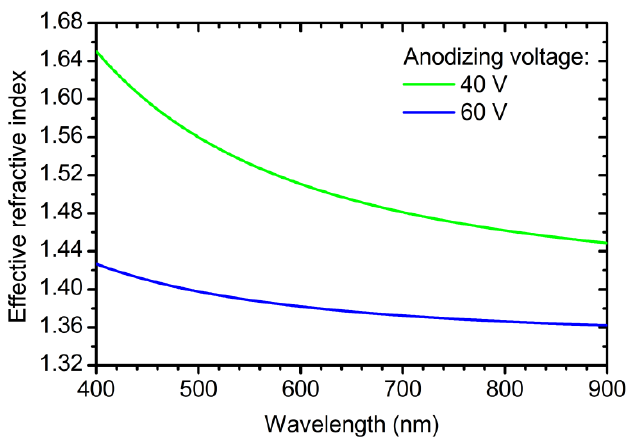
Figure 6. Cauchy dispersion ( n m ( λ ) = A m + B m / λ 2 ) of the effective refractive index of the photonic crystal layers obtained at different anodizing voltage: 40 V (green line, A m = 1.399, B m = 40260 nm 2 ) and 60 V (blue line, A m = 1.346, B m = 12930 nm 2 ) .